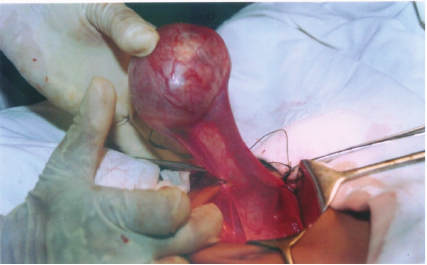
Figure 1: Per-operative photograph of cryptorchid testis.